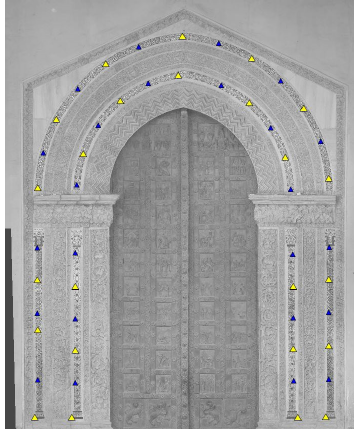
Figure 12. Ground control points (in yellow) and check points (in